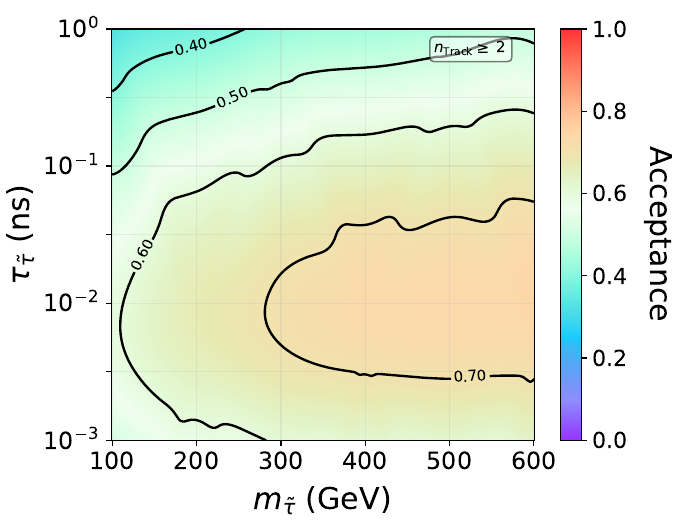
Figure 12. Acceptance for displaced lepton signature requiring at least two tracks and passing the requirements listed in table 2.